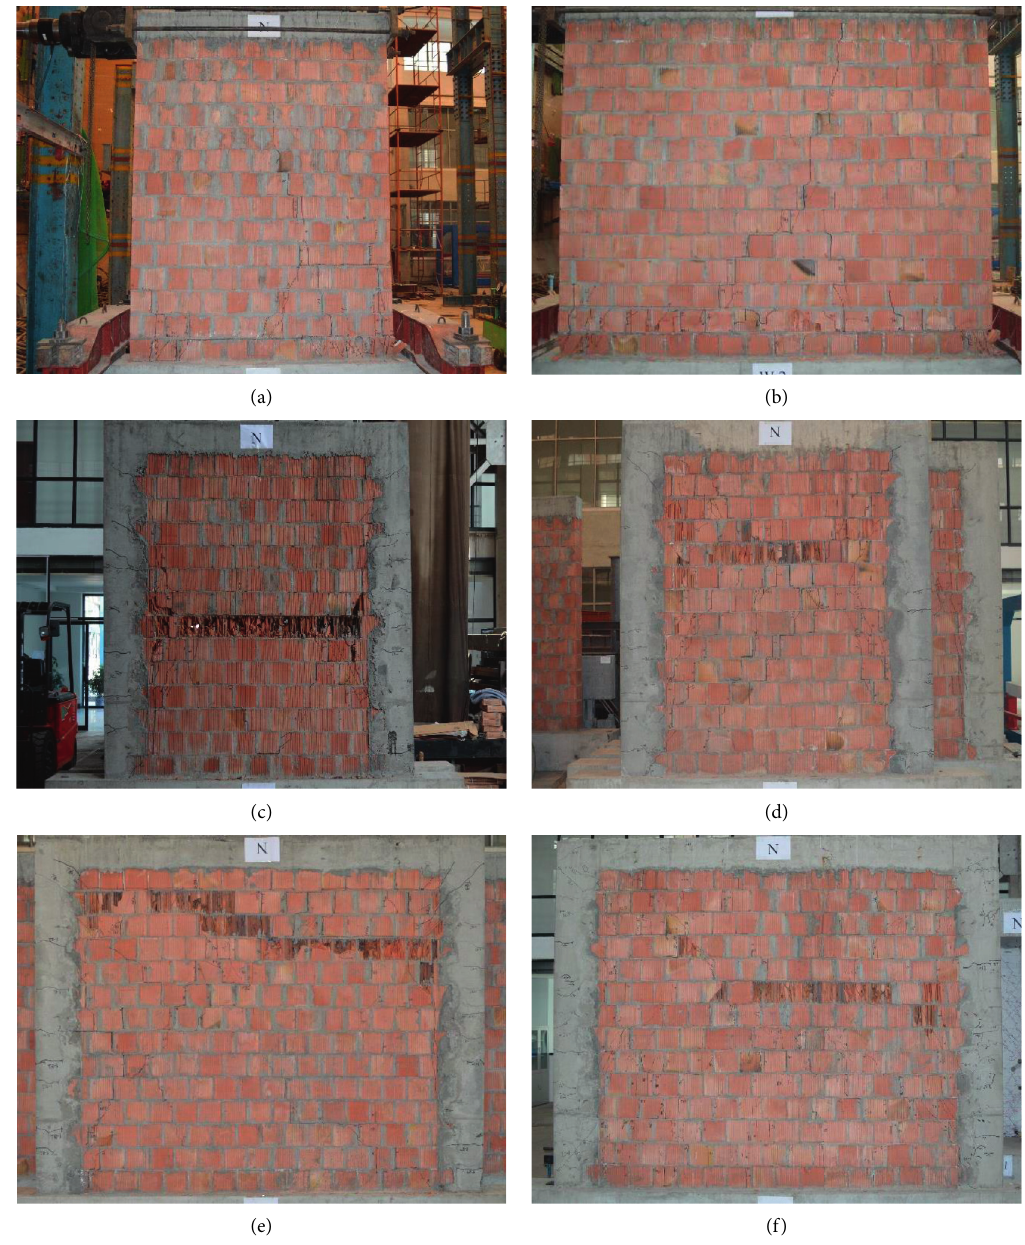
Figure 7: Failure mode of the specimens: (a) W1; (b) W2; (c) W3; (d) W4; (e) W5; (f)